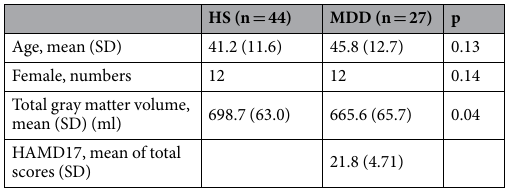
Table 1. Demographic and clinical characteristics of participants. Abbreviations: HS = healthy subjects; MDD = Major depression disorders; HAMD = 17-item Hamilton Rating Scale for